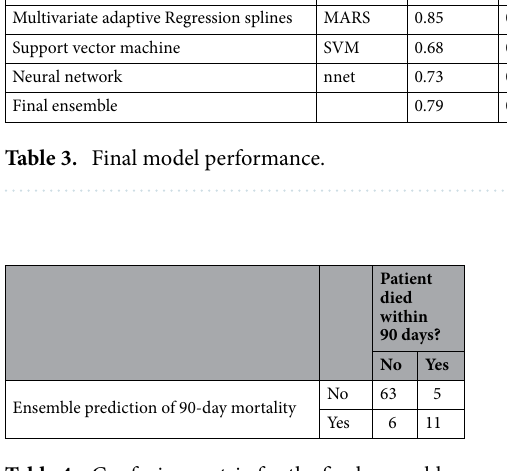
Table 4. Confusion matrix for the final